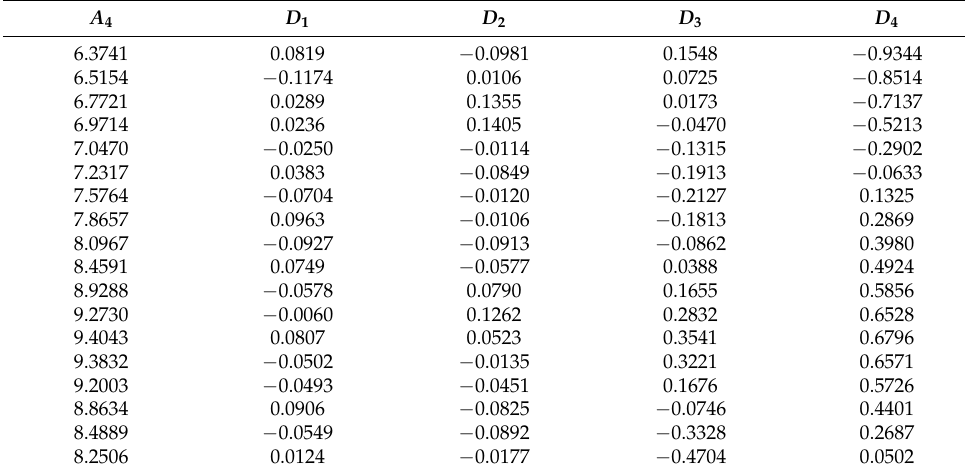
Table 6. Four-level wavelet decomposition of V 5 .